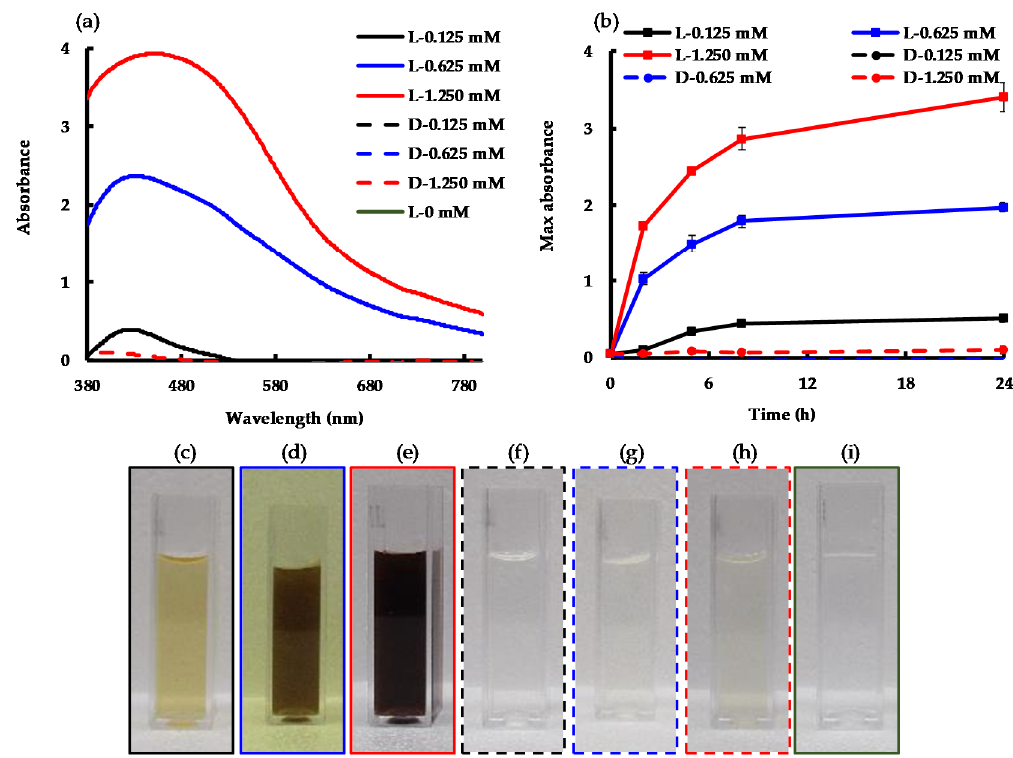
Figure 2. ( a ) Spectrophotometric measurements at 24 h; ( b ) Change of silver nanoparticle (AgNP) surface plasmon resonance (SPR) intensity vs. time over 24 h; ( c – i ) Reaction mixture in 1 cm pathlength cuvettes after 24 h of synthesis ( c ) L-0.125 mM; ( d ) L-0.625 mM; ( e ) L-1.250 mM; ( f ) D-0.125 mM ( g ) D-0.625 mM; ( h ) D-1.250 mM; ( i ) L-0 mM. “L-” indicates “in the light”; “D-” indicates “in the dark”; the values following are the concentrations of Ag + in the synthesis reaction. The border of each photo ( c – i ) matches the series lines in ( a , b ).